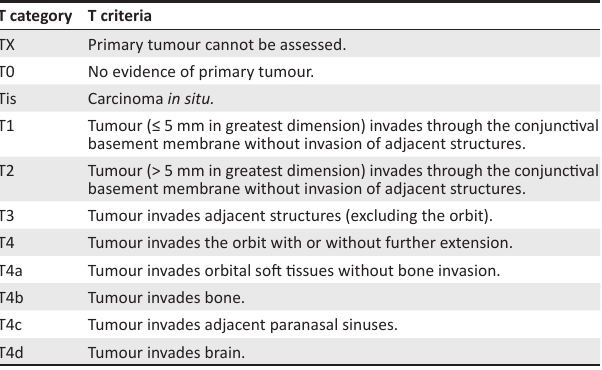
TABLE 1: American Joint Committee on Cancer staging for ocular surface squamous neoplasia. T category T criteria